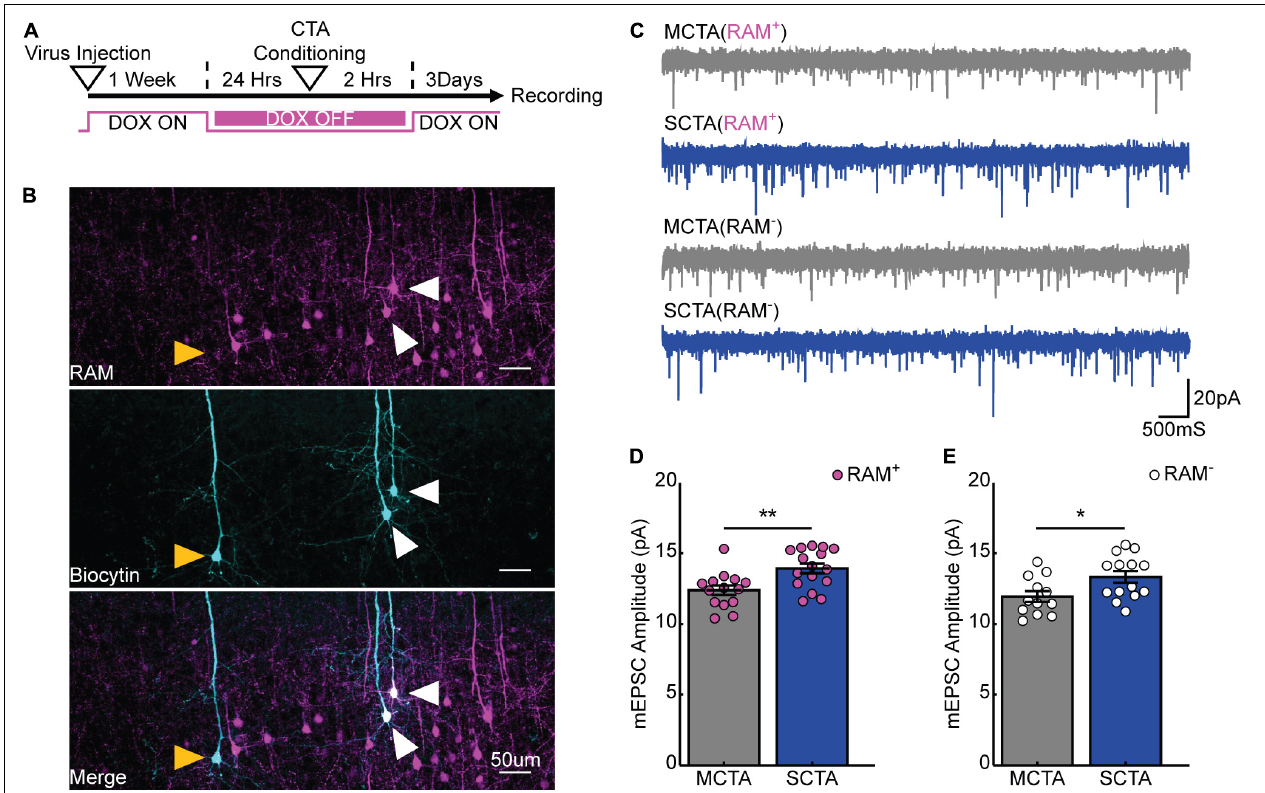
FIGURE 3 | Strong aversive conditioning drives a long-lasting increase in postsynaptic strength. (A) Experimental design. (B) Biocytin fills (cyan) of RAM + (magenta; white arrows) and RAM − (yellow arrows) pyramidal cells in gustatory cortex. (C) Representative mEPSC recordings. (D) Cell-average mEPSC amplitudes of RAM + cells 3 days post-conditioning (two-sample t test, p = 0.0035). (E) Cell-average mEPSC amplitudes of RAM − cells 3 days post-conditioning (two-sample t test, p =